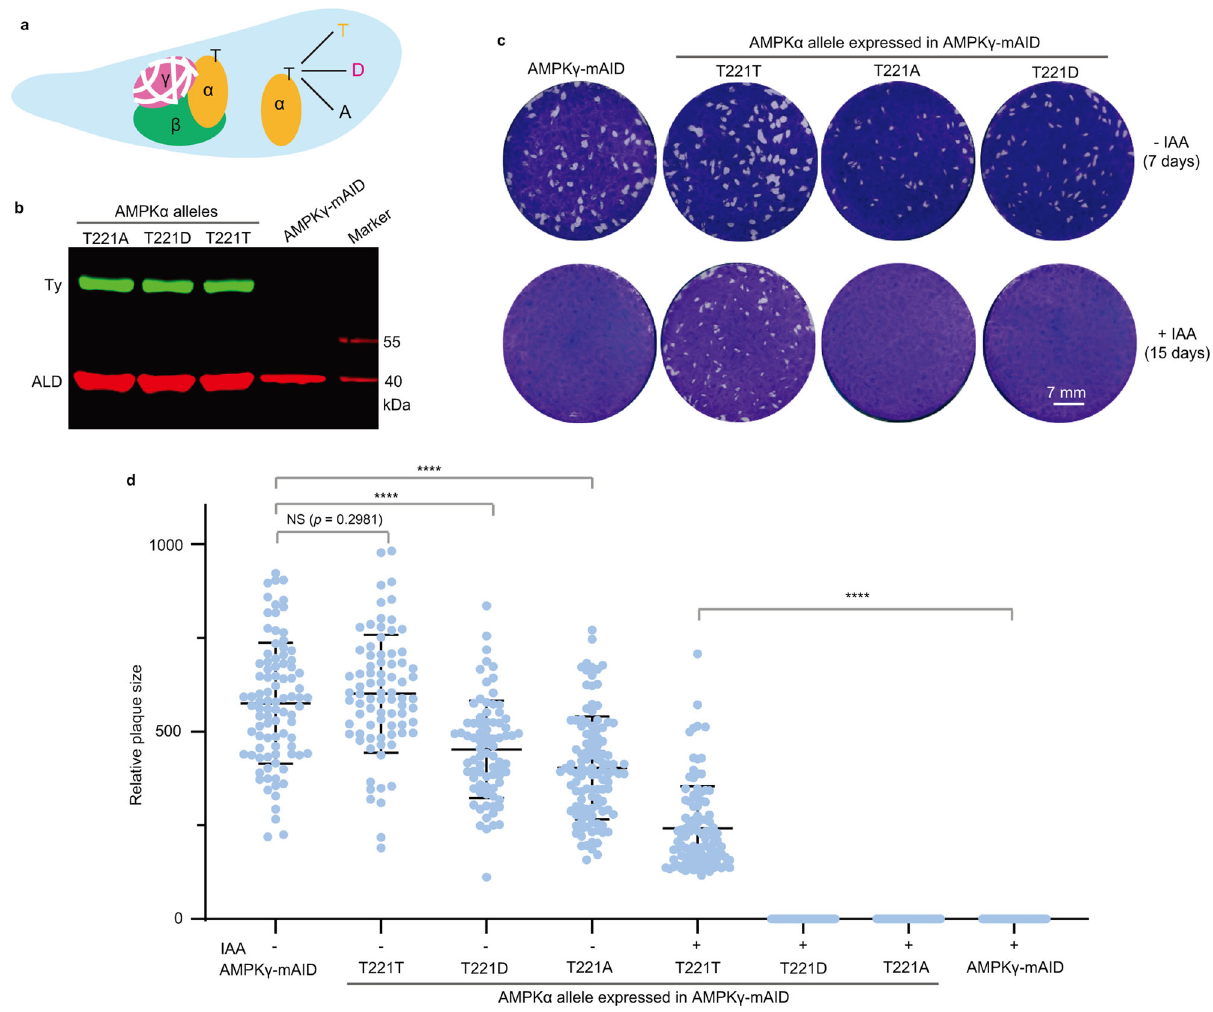
Fig.4|ImpactoftheexpressionofdifferentallelesofTgAMPK α onthegrowth of TgAMPK γ depleted parasites. a Schematic illustration of expressing the TgAMPK α -T221T,-T221D,or-T221AallelesinparasiteslackingTgAMPK γ ,whichwas achieved by IAA treatment of the AMPK γ -mAID mutant. The AMPK α